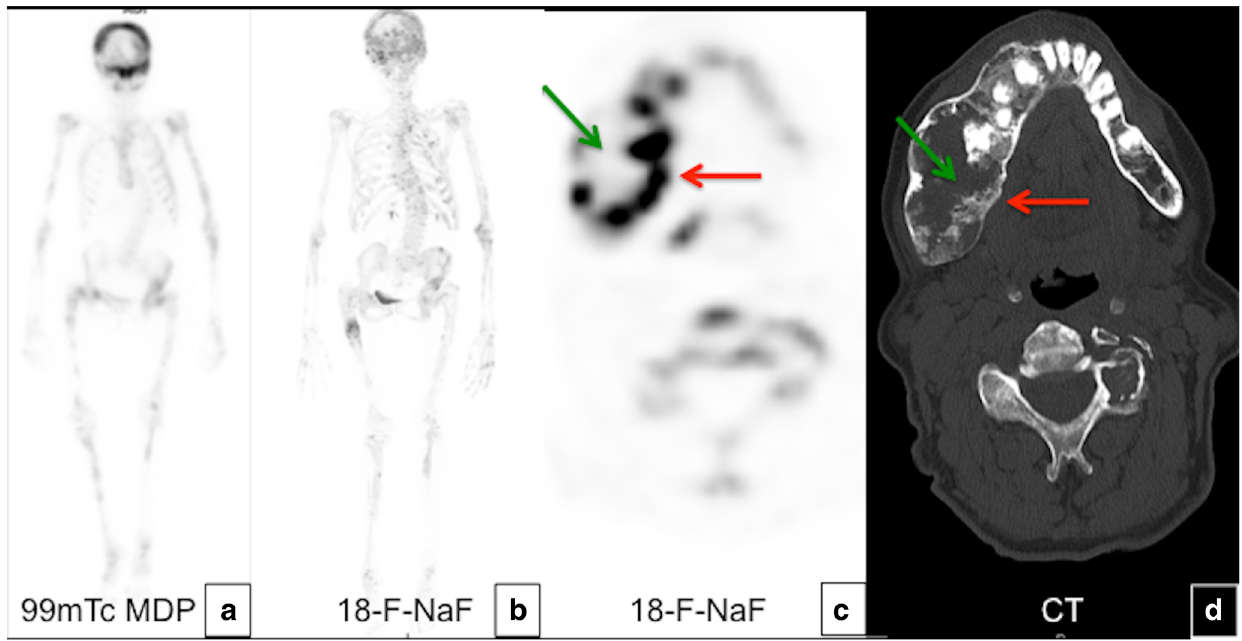
Fig. 10 Nuclear medicine imaging in fibrous dysplasia (FD). a Bone scans with 99m-Tc-MDP are exquisitely sensitive at detecting the presence and extend of the disease. b 18-F-NaF on the same patient with polyostotic FD demonstrates multiple areas of focal radiotracer